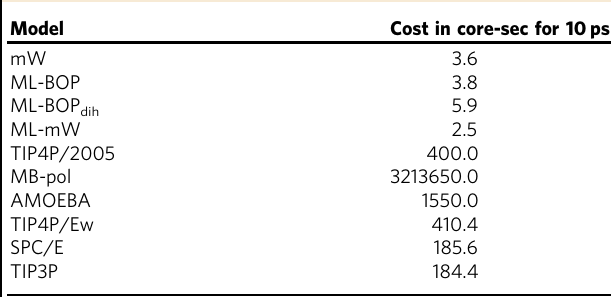
Table 2 Comparison of the computational cost for